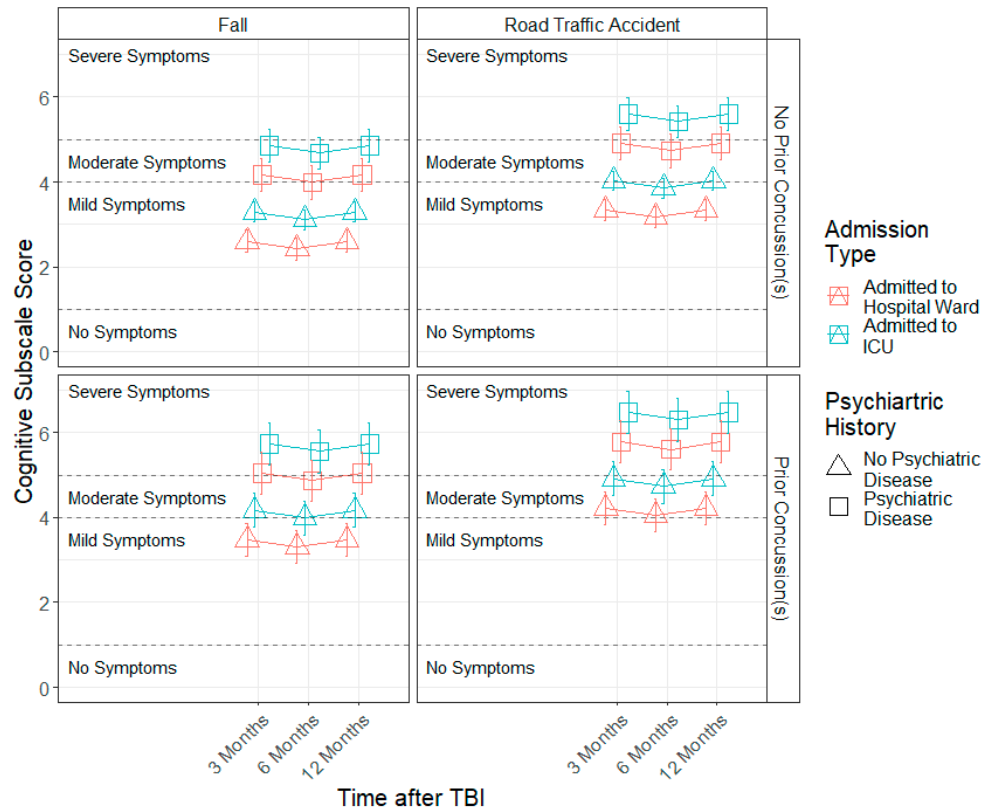
Figure 3. Modelled trajectories for the emotional factor by significant predictors.